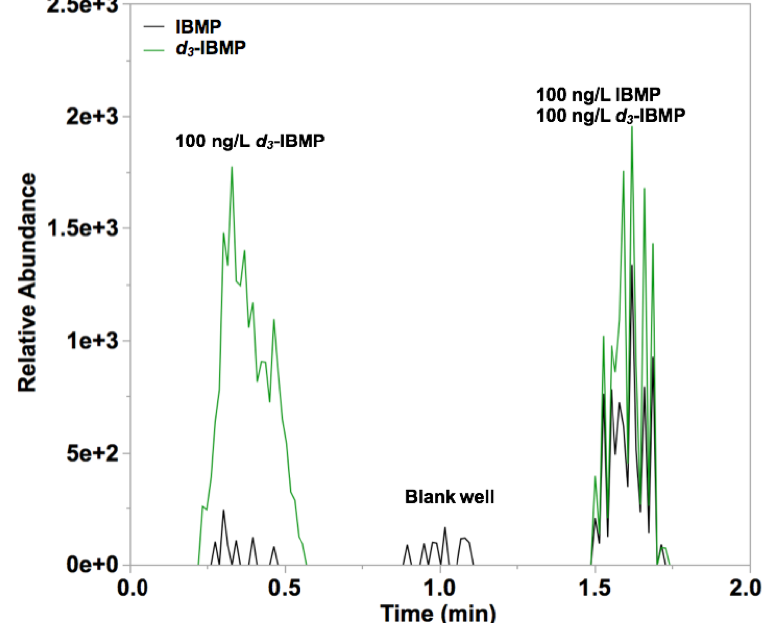
Figure 2. DART-Orbitrap-MS chronograms of extracted ions for IBMP (2-isobutyl 3-methoxypyrazine) 167 > 124.0632 m / z and d 3 -IBMP 170 > 127.0818 m / z in Pinot noir homogenate (contains no native IBMP); ( left ) spiked with only internal standard, ( middle ) blank well and ( right ) spiked with both standard and internal